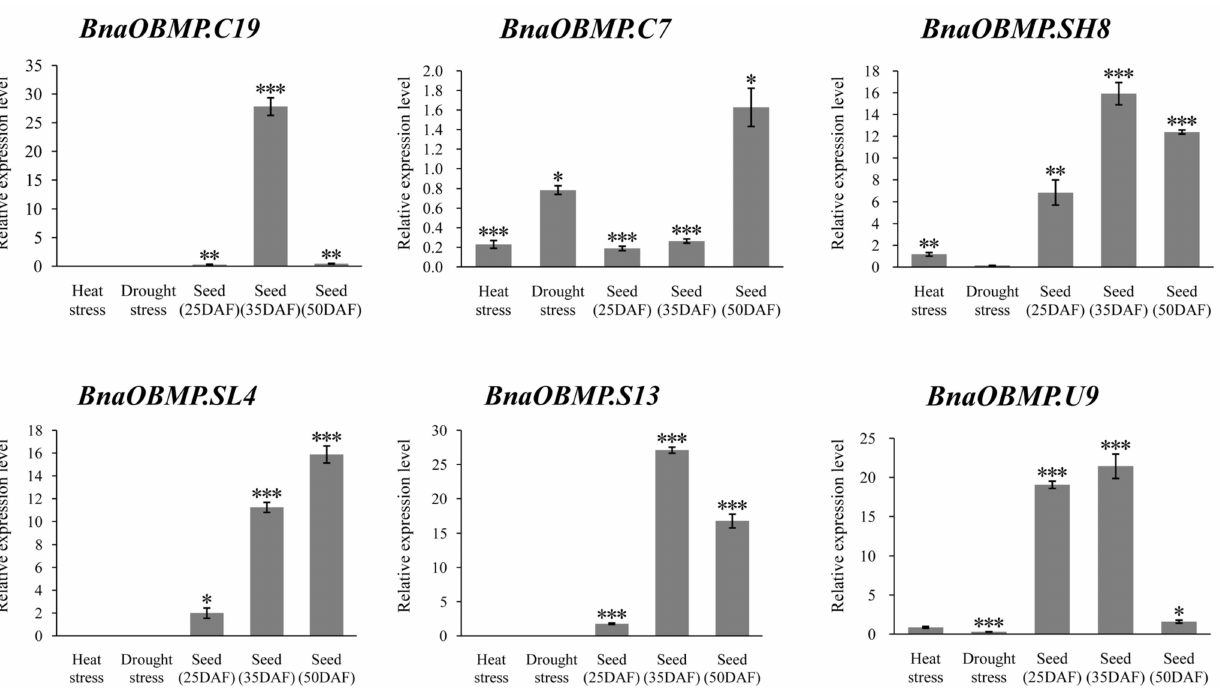
Figure 7. qRT-PCR verification that the expression of some representative BnaOBMP genes responded to heat and drought stresses (leaves) as well as during seed development. Statistically significant differences (Student’s t -test) are indicated as followed: * p < 0.05, ** p < 0.01, *** p <